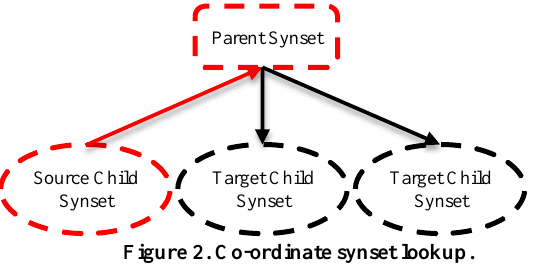
Figure 2. Co-ordinate synset